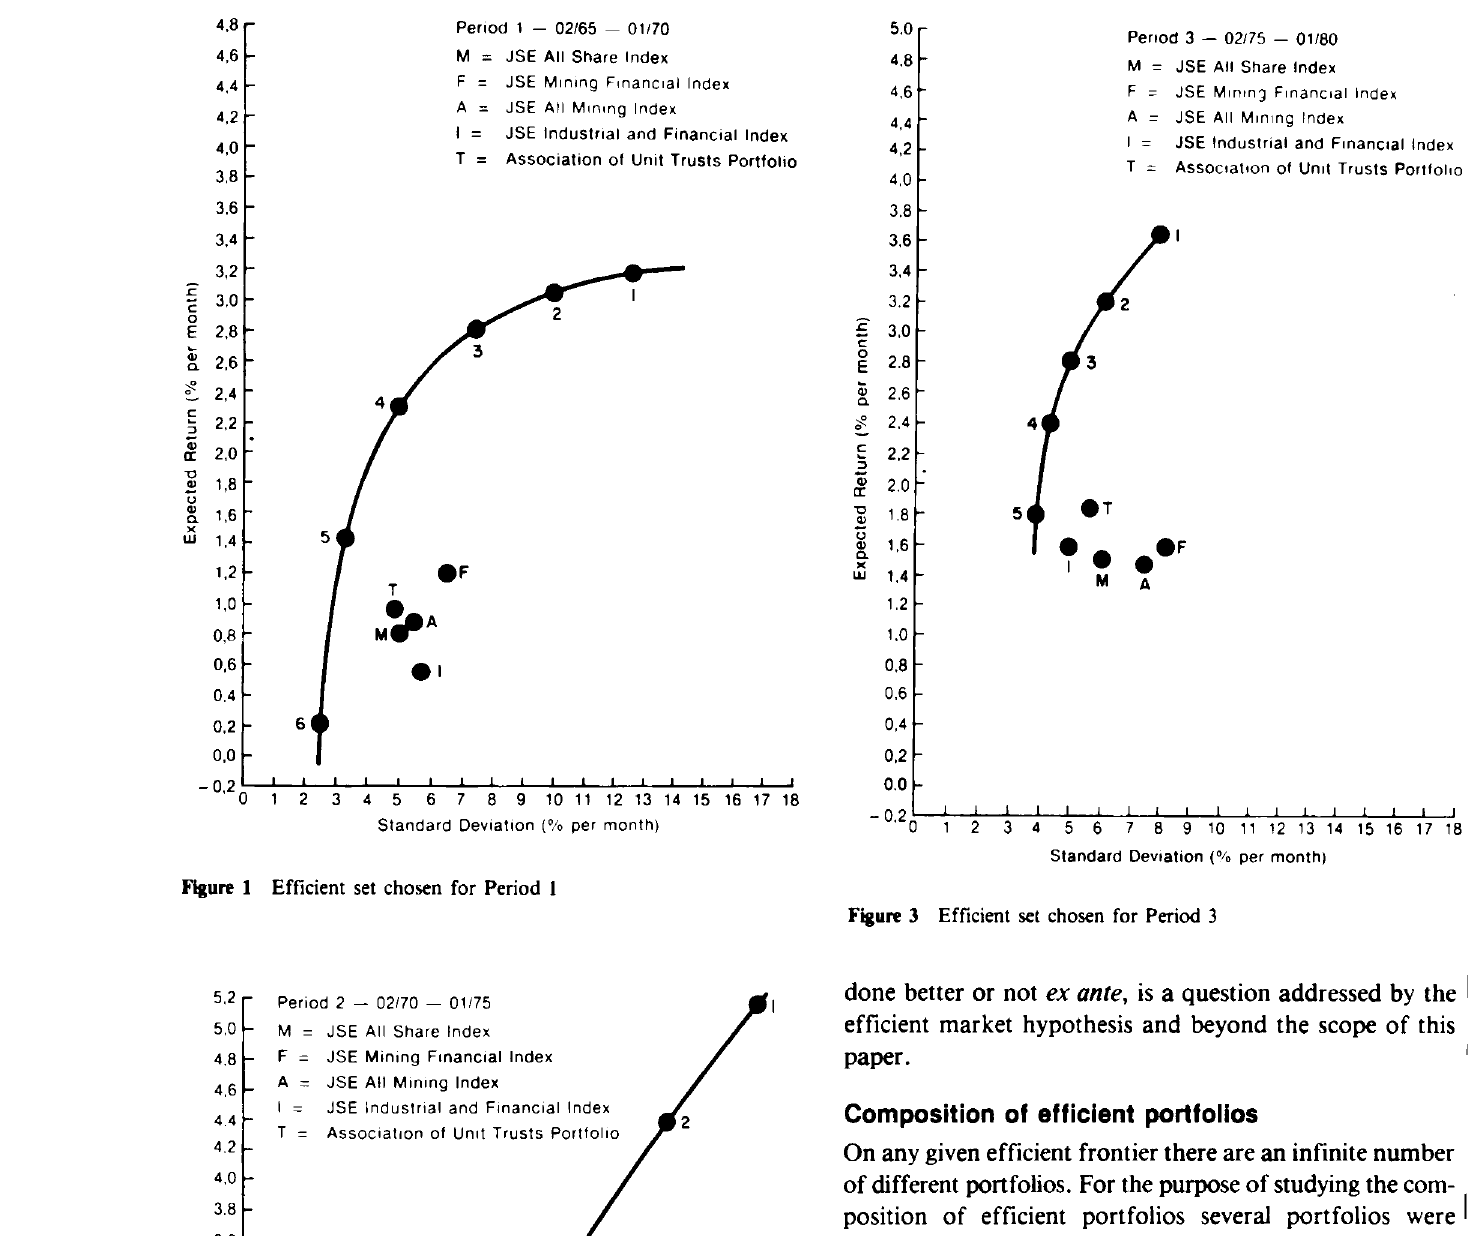
Figure 3 Efficient set chosen for Period